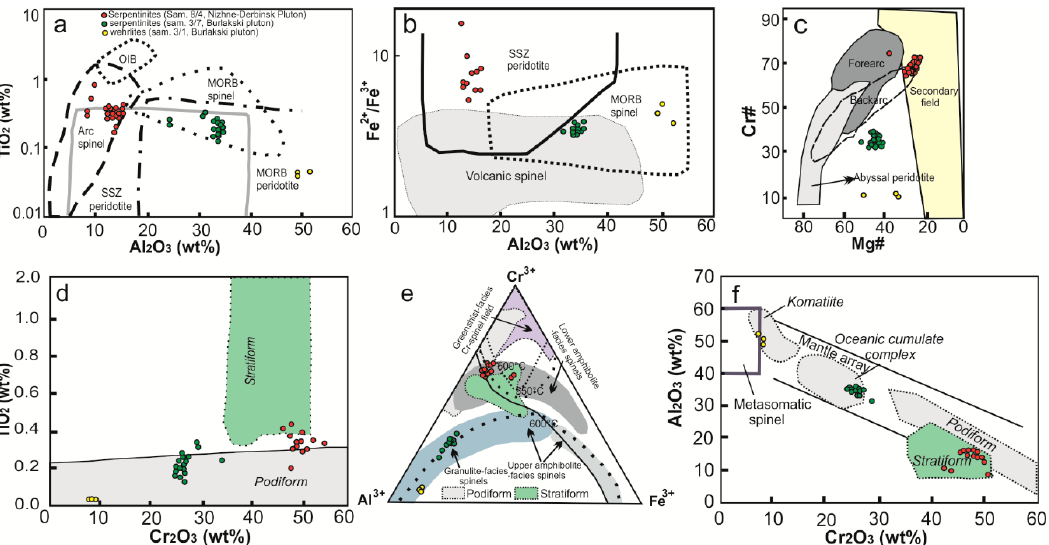
Figure 9. Binary and ternary diagrams comparing the composition of chromian spinels from the Burlakski and Nizhne-Derbinsk plutons to those from di ff erent tectonic settings. ( a,b ) TiO 2 vs. Al 2 O 3 ., Al 2 O 3 vs. Fe 2 +/ Fe 3 + diagrams that discriminate chromian spinel from supra-subduction zone (SSZ) and mid-ocean ridge basalt (MORB) peridotites (fields from [45]). ( c ) Mg# vs. Cr# diagram. The fields of abyssal and forearc peridotites is from [5]. The secondary field is from [82]. ( d ) Cr 2 O 3 vs. TiO 2 . ( e ) Al–Cr–Fe 3 + ternary diagram. The spinel stability limits are from [45]. Cr-Al trend is from [6]. ( f ) Cr 2 O 3 vs. Al 2 O 3 . The podiform and stratiform fields are from [83] and [84]. The field for di ff erent metamorphic facies are from [71] and [85].